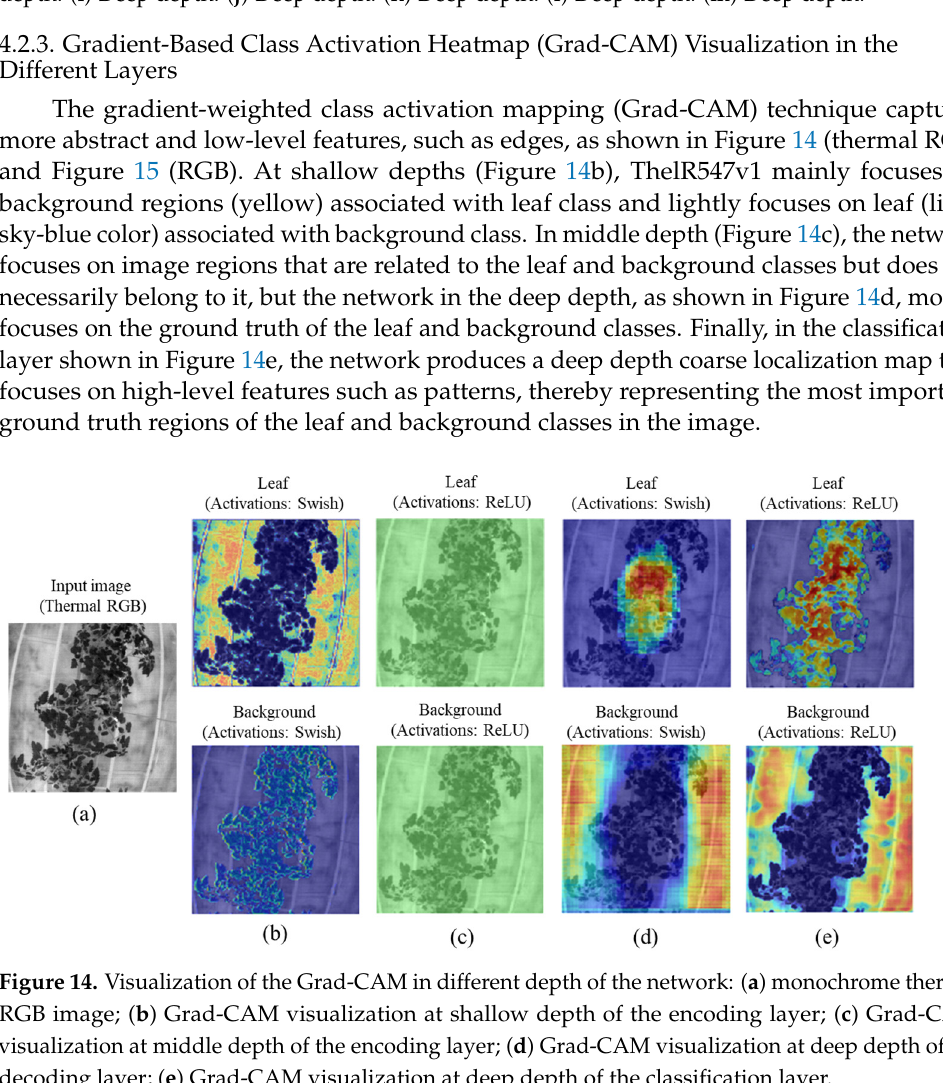
Figure 13. Visualization of the network activated feature maps. ( a ) Shallow depth. ( b ) Middle depth. ( c ) Deep depth. ( d ) Shallow depth. ( e ) Middle depth. ( f ) Middle depth. ( g ) Middle depth. ( h ) Deep depth. ( i ) Deep depth. ( j ) Deep depth. ( k ) Deep depth. ( l ) Deep depth. ( m ) Deep depth.